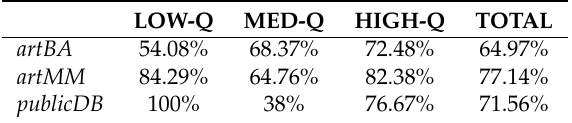
Table 3. Detection accuracy values obtained from the threshold-based method for each class of contaminated segments (LOW-Q, MED-Q and HIGH-Q) in the labelled